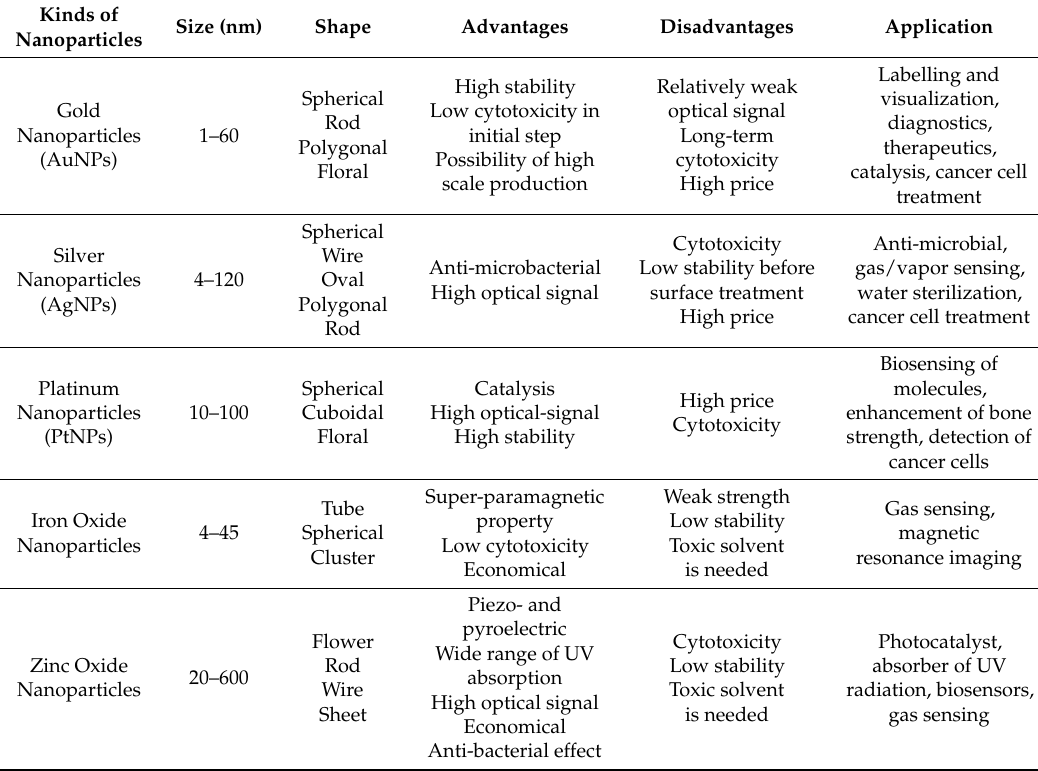
Table 1. Properties of Metal